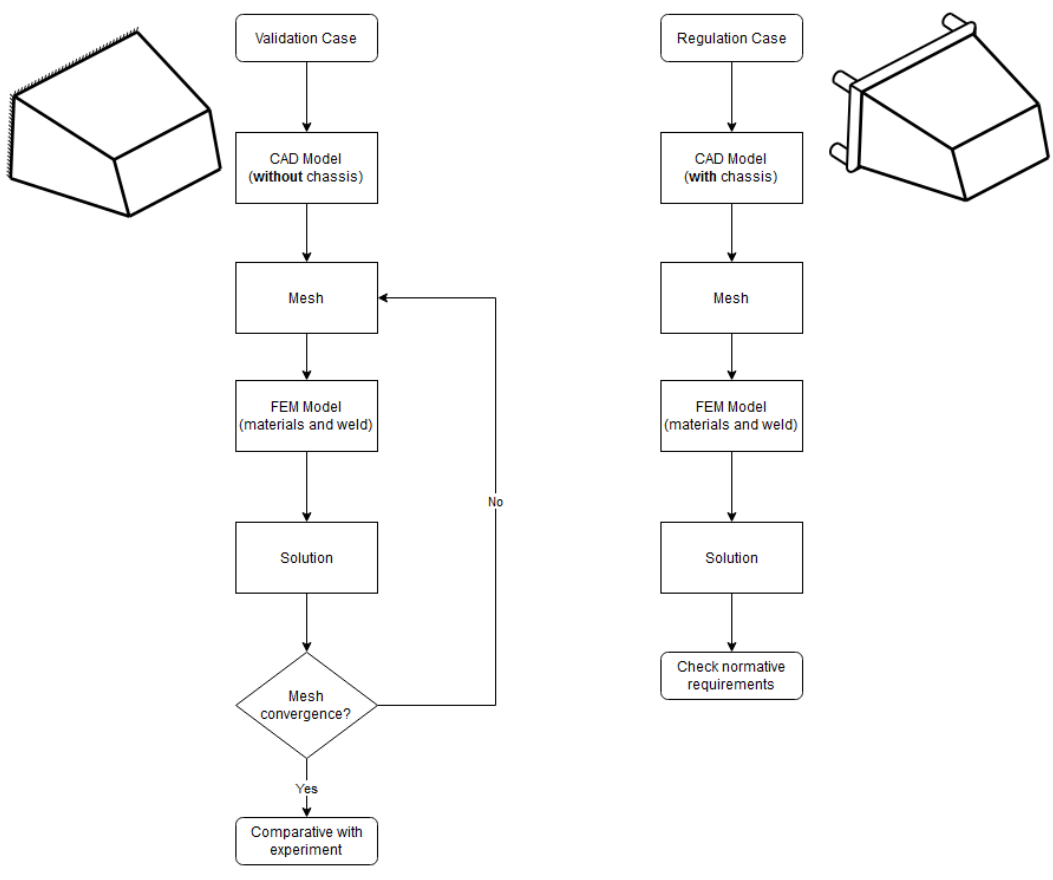
Figure 3. Flow chart of the numerical